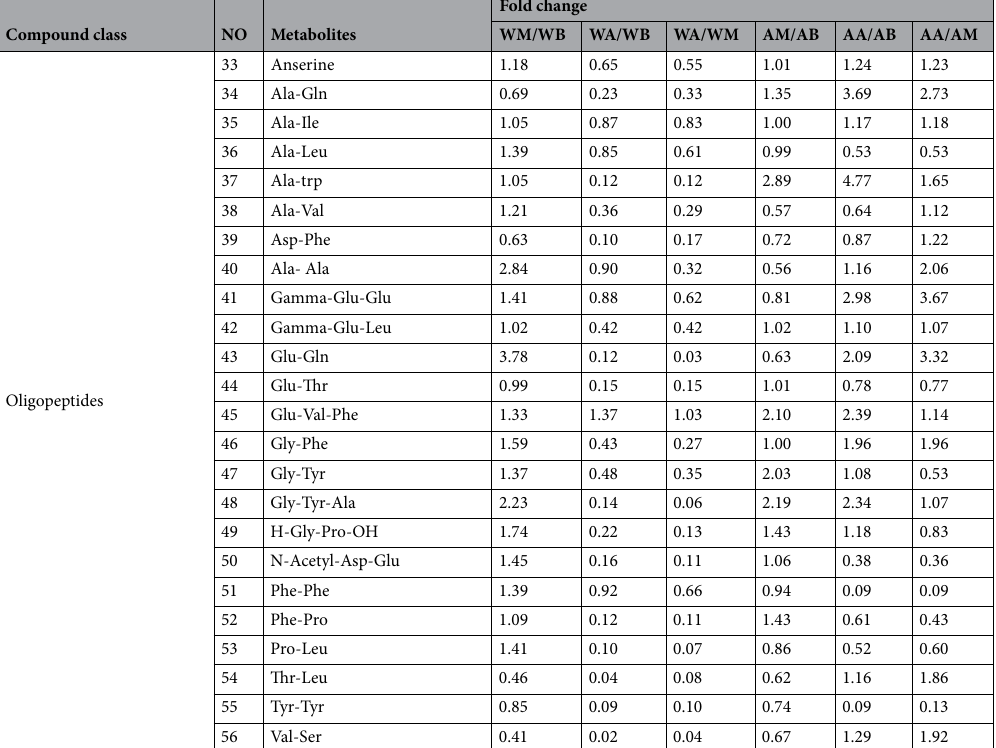
Table 1. Summary of sugars, amino acids metabolites, and oligopeptides were annotated in Inonotus hispidus. WM/WB: The ratio of the mature period to budding period of wild Inonotus hispidus . WA/WB: The ratio of the mature period to budding period of wild Inonotus hispidus . WA/WM: The ratio of the aging period to mature period of wild Inonotus hispidus. AM/AB: The ratio of the mature period to budding period of artificially cultivated Inonotus hispidus . AA/AB: The ratio of the aging period to budding period of artificially cultivated Inonotus hispidus . AA/AM: The ratio of the aging period to mature period of artificially cultivated Inonotus